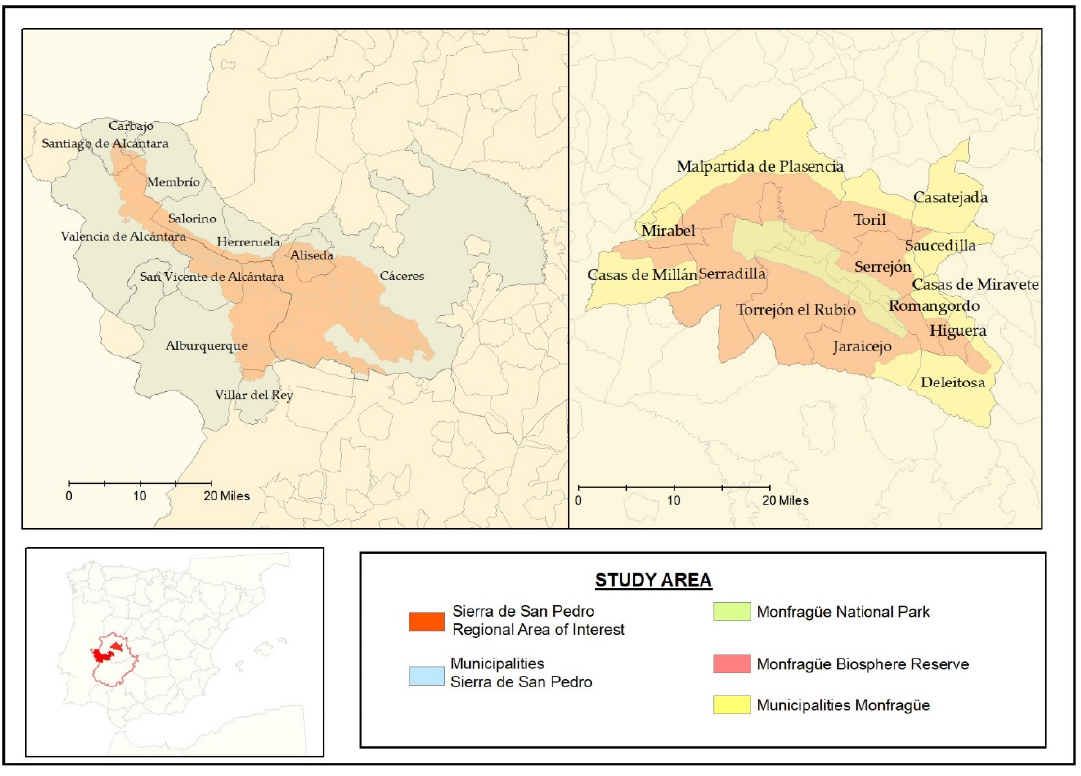
Figure 1. Study Figure 1. Study area.